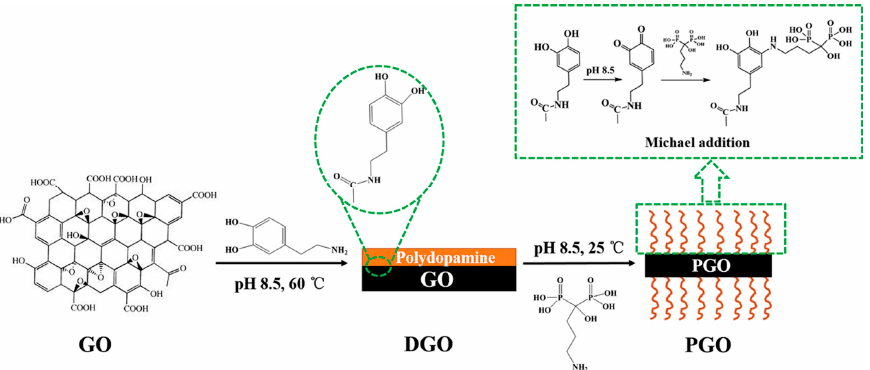
Figure 5. Synthetic process of DGO (polydopamine modified GO) and PGO (phosphonic acid functionalized GO) [111].